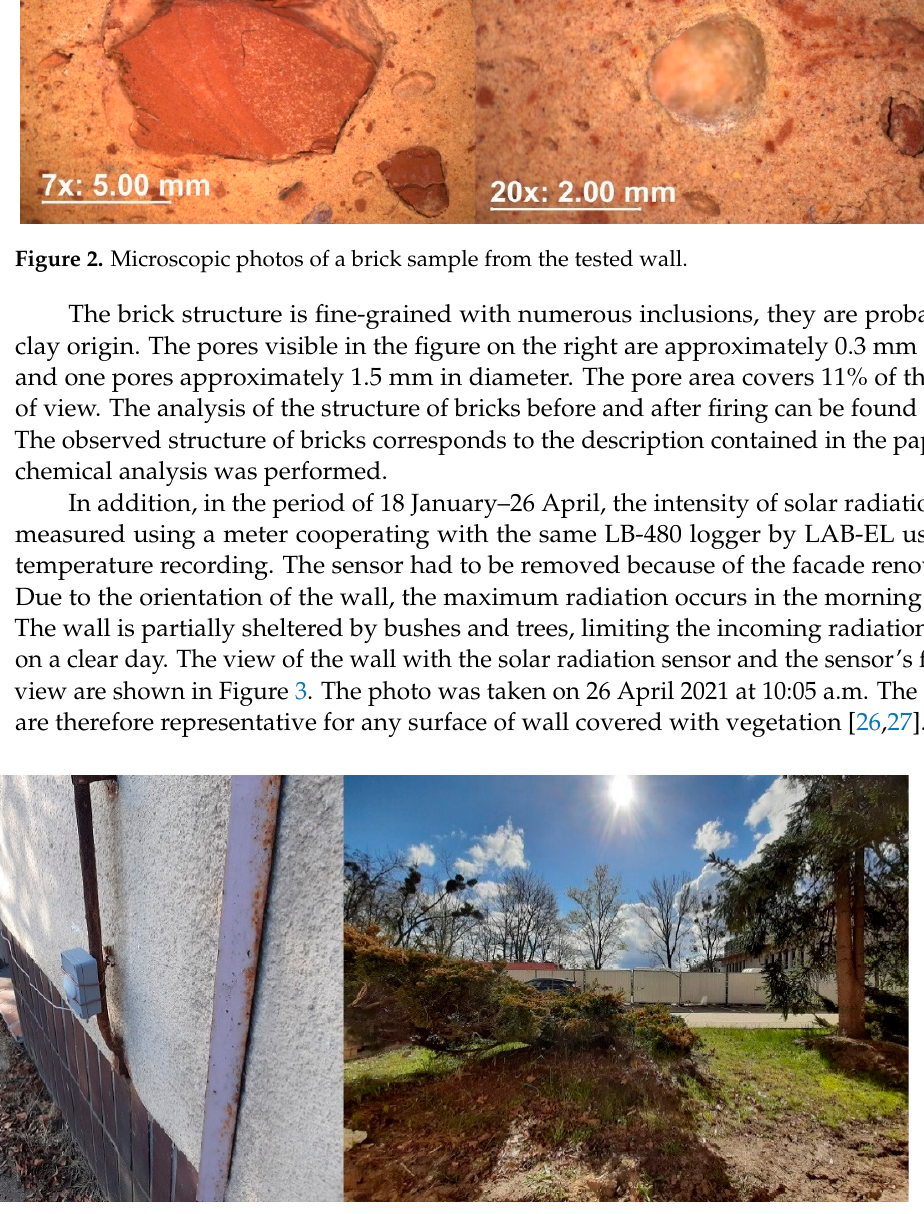
Figure 3. View of the tested wall and field of view of the solar radiation sensor. The obtained temperature values from the recorded field were approximated by a third-degree polynomial and then the regular field of temperature was calculated. The coordinate system corresponds to that adopted in [28]. Each of the calculated temperatures represents the average temperature of an element with a width of ∆ x equal to one centimeter. The elements are numbered from 1 to 60 as shown in Figure 4. The approximated temperature distribution contains values in regular spacing in contrast to measures values, so it was named “regular temperature grid”. Temperature T i , n denotes the temperature approximated at point i ( i = 1 . . . 60) at time n.